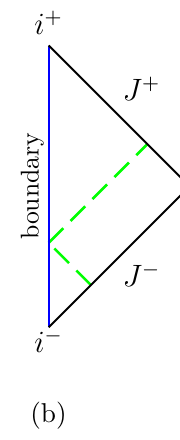
Figure 1 . Penrose diagrams of Minkowski vacuum in the (a) original CGHS model and (b) model with a boundary. The dashed lines are light rays extending from J (cid:0) to J +